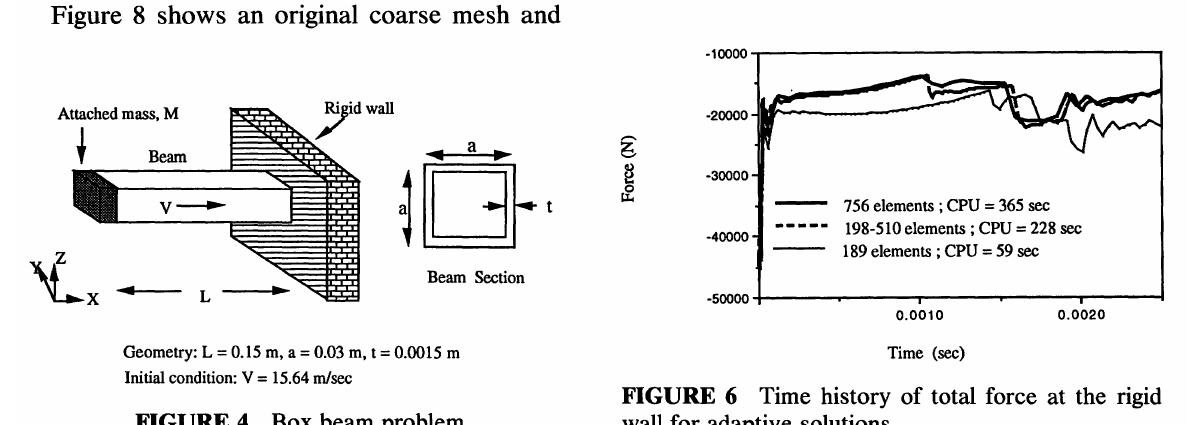
FIGURE 4 Box beam problem.